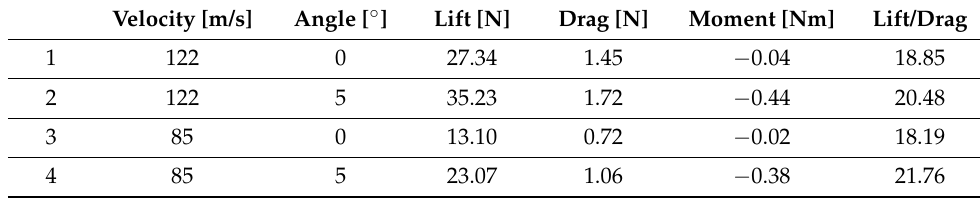
Table 3. Values of forces acting on the NACA 6412